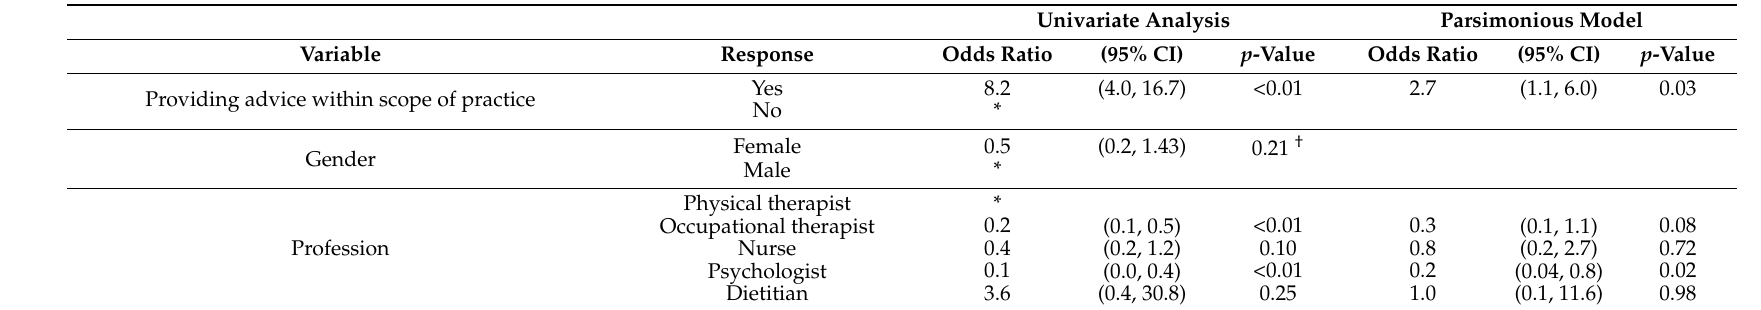
Table 6. Logistic regression modelling of factors associated with providing physical activity